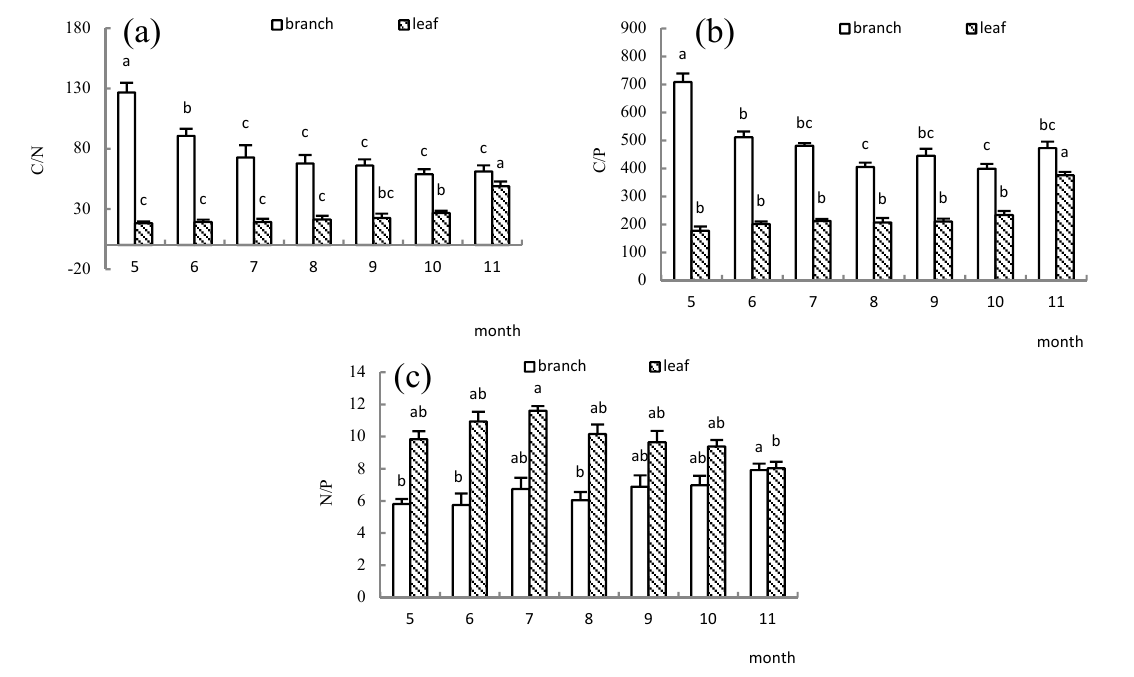
7 of 15 Figure 3. Monthly dynamic of C/N ( a ), C/P ( b ), N/P ( c ) ratios in different organs of female plants of F. velutina . Note: Means of different months not sharing the same letter indicated significant differ- ences at an alpha level of 0.05, according to an LSD test. In the growing season, both the C/N and C/P ratios of the branch or fruit of female plants showed a downward trend, especially after September. The leaf C/N ratios of fe- male plants showed a gradual upward trend in the growing season, while the leaf C/P ratios remained stable, except in November. The leaf C/N and C/P ratios in November were significantly greater than those in other months. The monthly change trends of the C/N and C/P ratios in different organs were opposite to those of the N contents and P contents, respectively, which showed that the variation in the two ratios were mainly de- termined by the N and P contents (Figures 1 and 3). The leaf N/P of female plants ranged from 6.60 to 11.62, the branch N/P varied from 5.80 to 8.01, and the fruit N/P varied from 5.41 to 7.12 (Figure 3c). The N/P ratios of branch and fruit gradually increased during the growing season, while the N/P ratio of leaf grad- ually decreased during this period. In each month of the growing season, the N/P ratios of fruit and branch were all relatively similar. The leaf N/P of female plants was signifi- cantly greater than that of branch and fruit in the early and middle growing season, while the leaf N/P was close to that of branch and fruit in the late growing season. 3.4. Dynamics of C/N/P Ratios in Different Organs of Male Plants of F. velutina The leaf C/N ratios of the male plants of F. velutina ranged from 18.18 to 48.87, and the branch C/N ratios varied from 58.85 to 126.72 (Figure 4a). The range of the leaf C/P ratios of male plants was 177.40–376.12 (Figure 4b), while the range of the branch C/P